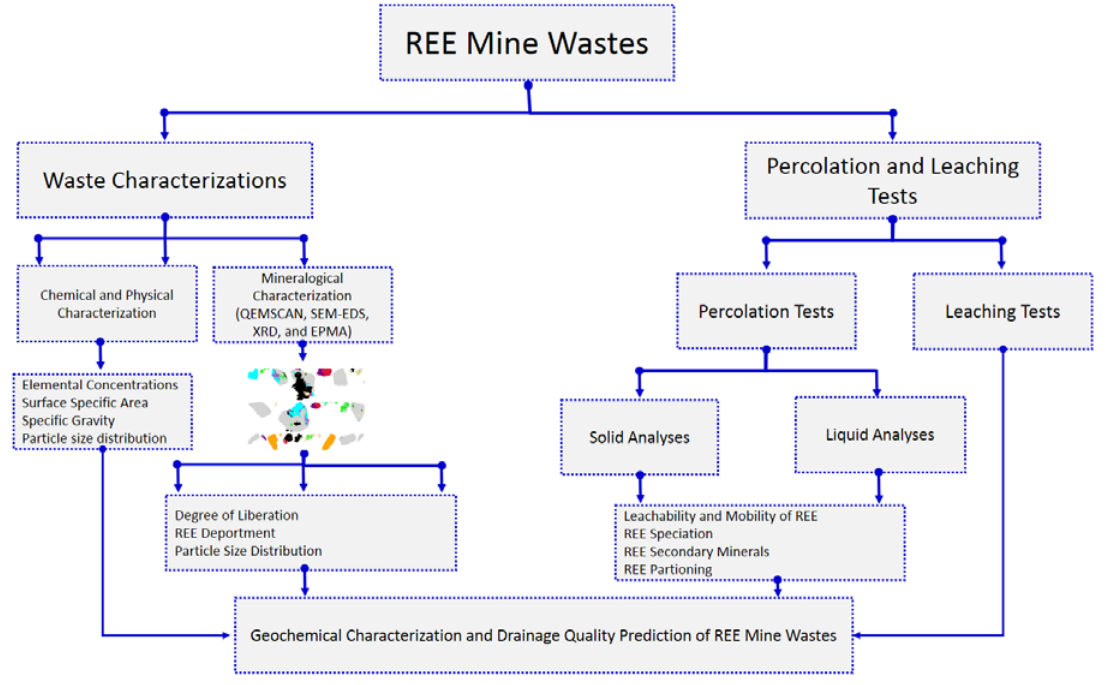
Figure 12. Approach to predict geochemical behavior of REE mine wastes.